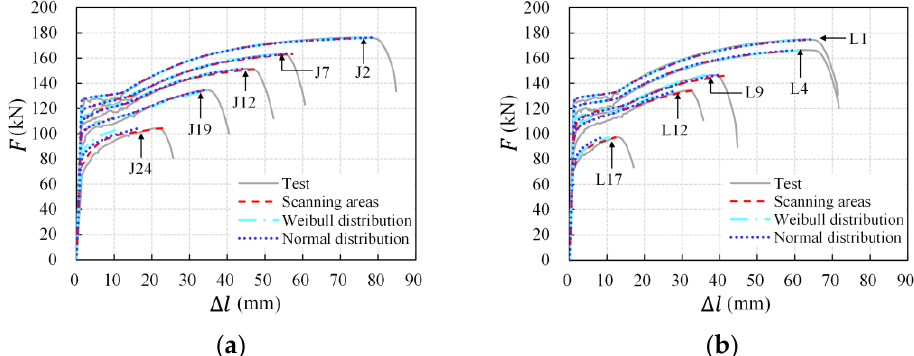
Figure 21. Calculation of load-deformation curves of corroded rebars based on simulating cross- sectional areas: ( a ) intact slabs; ( b ) pre-cracked slabs.